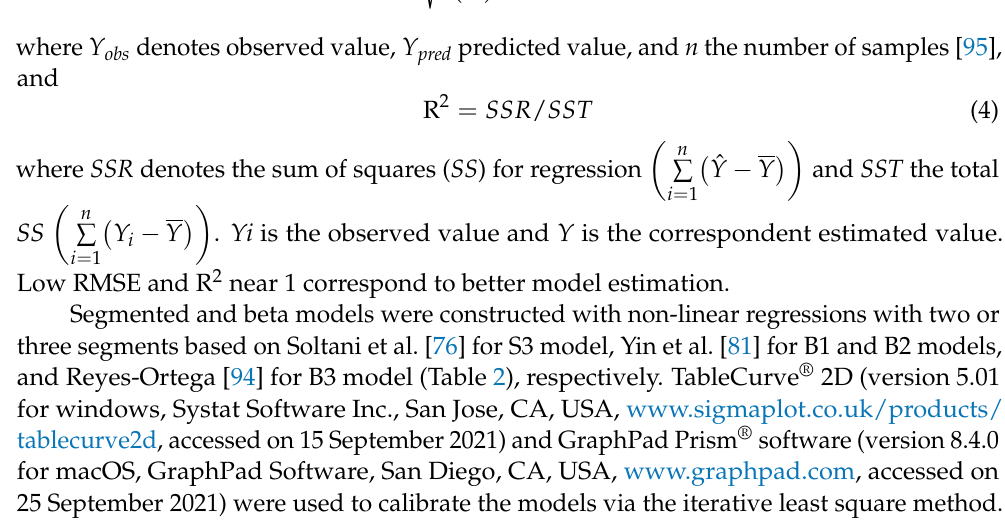
tablecurve2d, accessed on 15 September 2021) and GraphPad Prism ® software (version 8.4.0 for macOS, GraphPad Software, San Diego, CA, USA, www.graphpad.com, accessed on 25 September 2021) were used to calibrate the models via the iterative least square